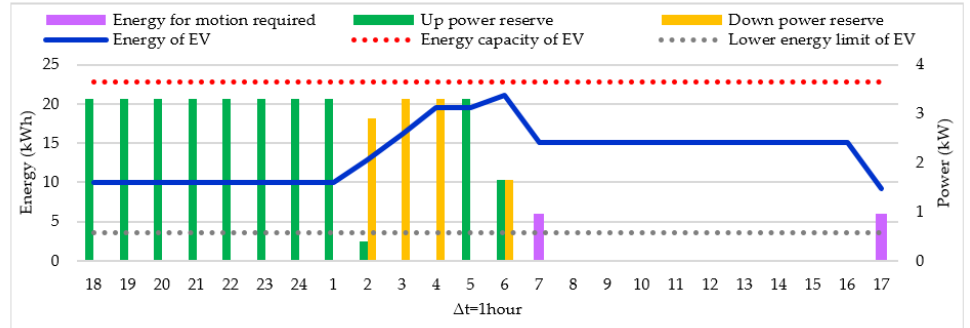
Figure 5. Charging behavior and offers of reserve services of EV # 4 on a weekday.